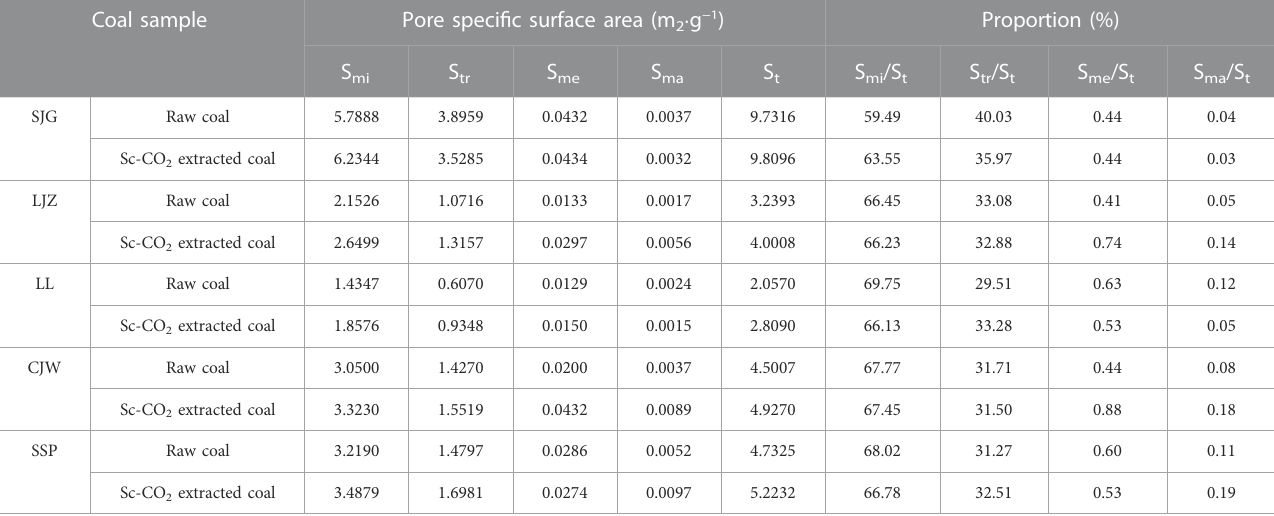
TABLE 3 Pore-speci fi c surface area of the samples before and after the Sc-CO 2 extraction. Coal